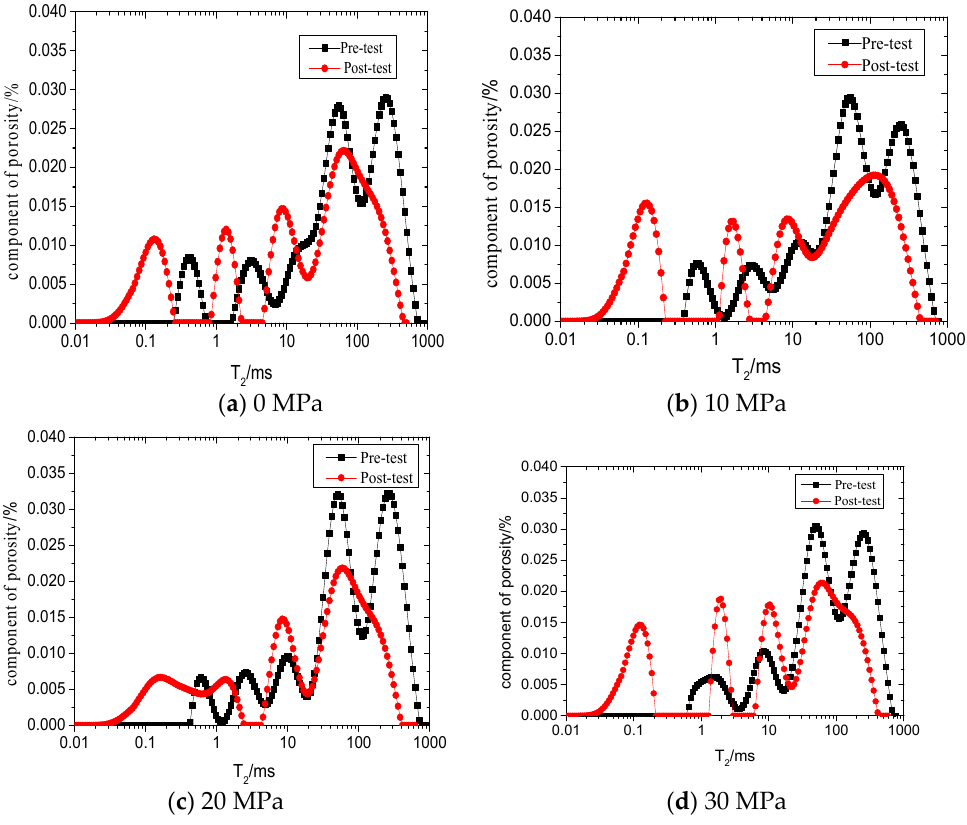
Figure 9. T 2 distribution of of rock samples uder different axial pre-stresses ( a ) 0 MPa, ( b ) 10 MPa, ( c ) 10 MPa and ( d ) 30 MPa.